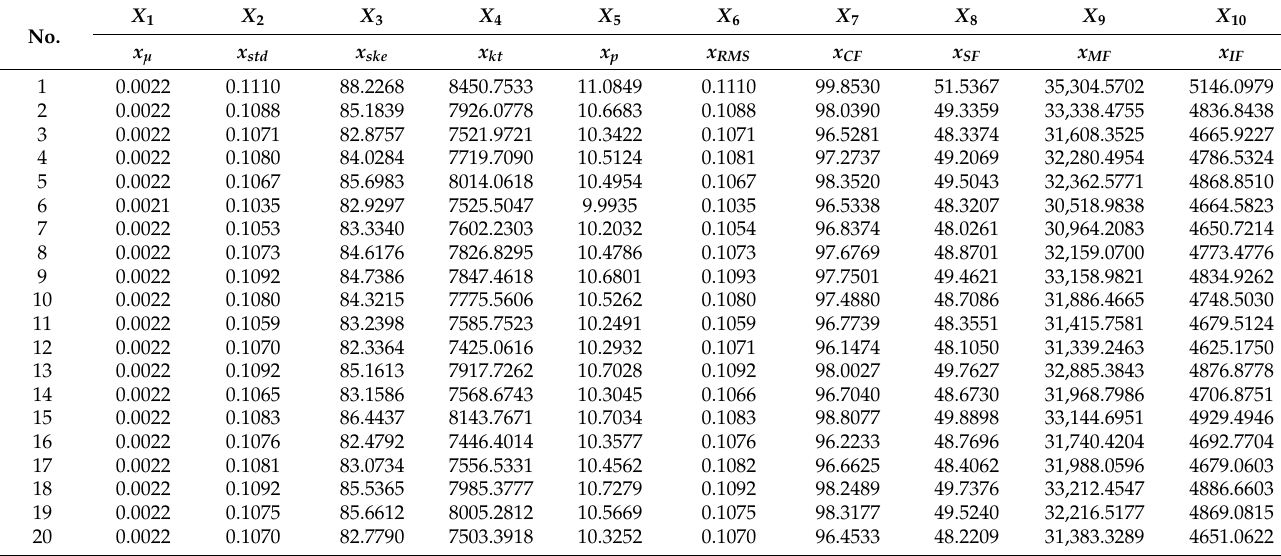
Table A1. SCI values extracted from the normal data in the training